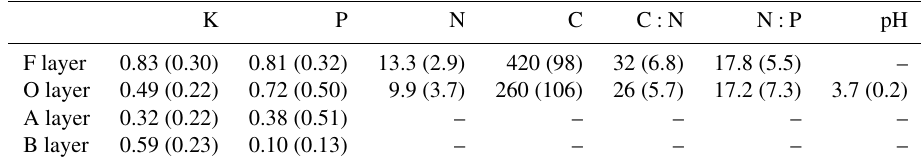
Table C1. Average total contents of elements (gkg − 1 ) in soil layers and their standard deviations in parentheses. All plots are included. K